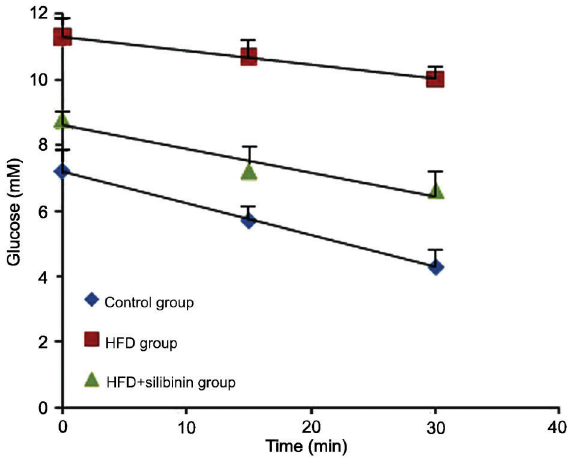
Figure 3. Insulin tolerance test (ITT) applied to each group. The ITT slope (K ITT ) represents the degree of insulin resistance. The lower the K ITT , the more serious the insulin resistance. The high- fat diet (HFD) group showed the lowest K ITT , which was increased in the silibinin group (HFD +